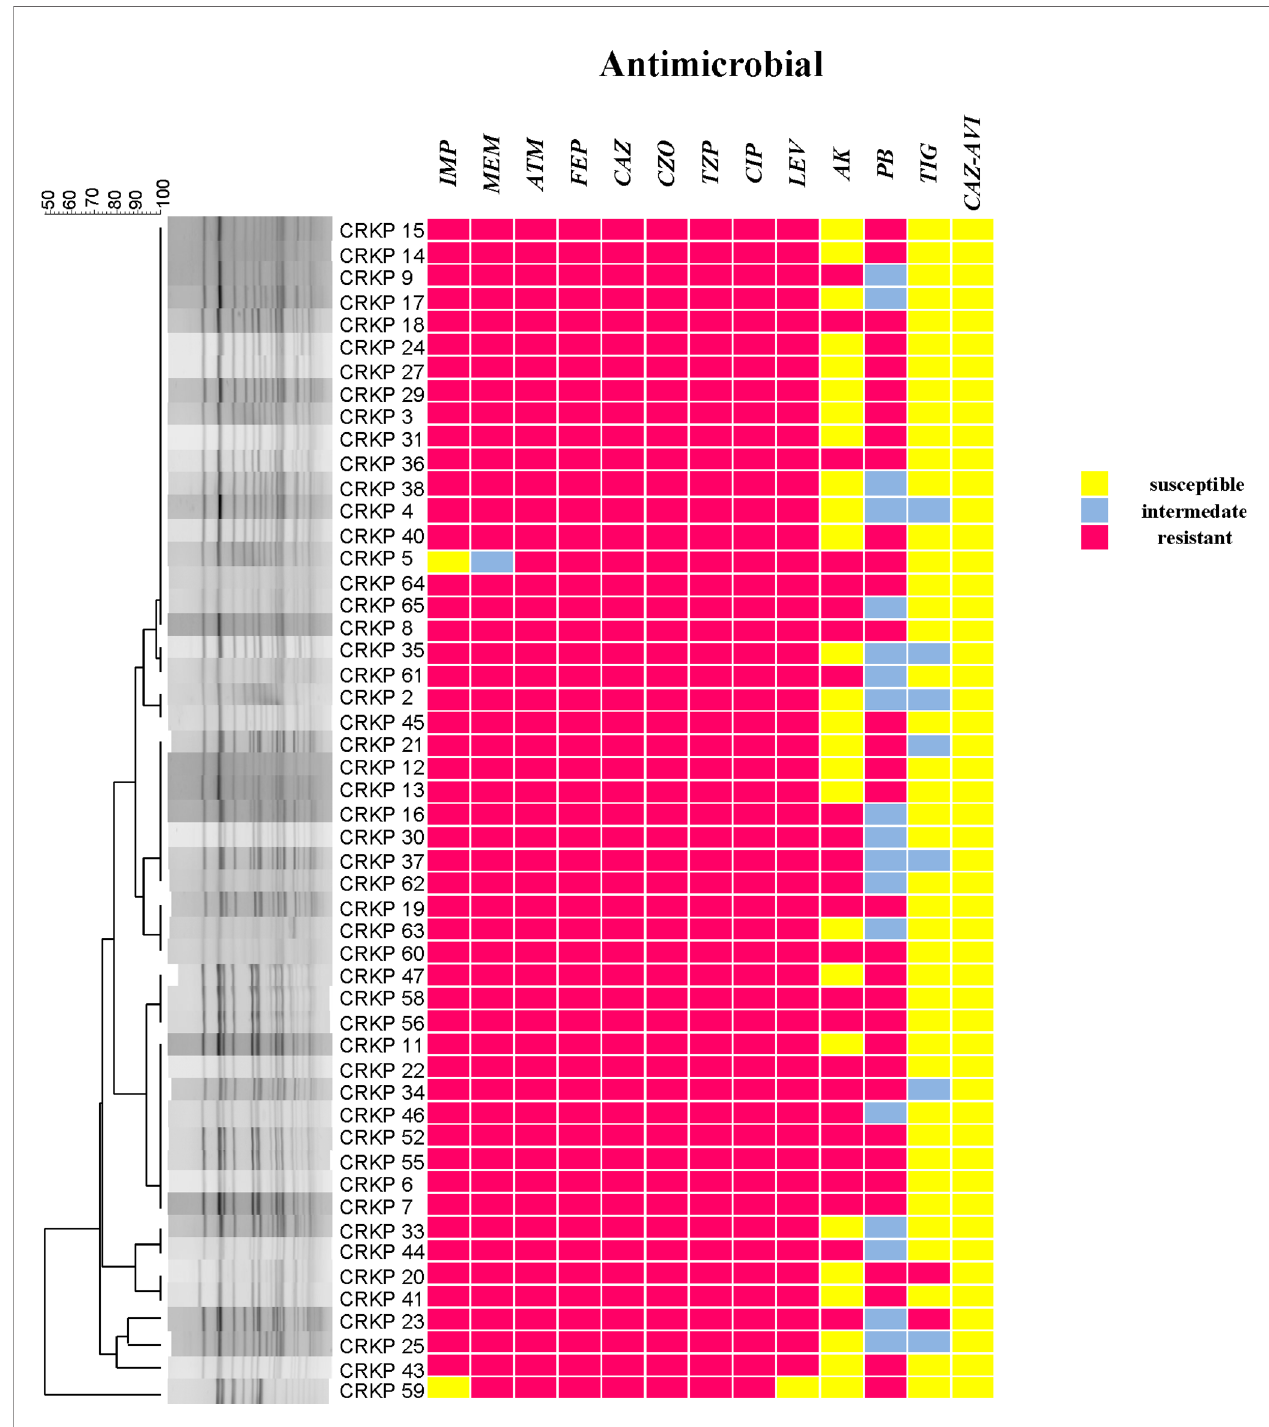
FIGURE 2 | CRKP genetic similarity and antibiotic sensitivity. IMP, Imipenem; MEM, Meropenem; ATM, Aztreonam; FEP, Cefepime; CAZ, Ceftazidime; CZO, Cefazolin; TZP, Piperacillin tazobactam; CIP, Cipro fl oxacin; LEV, Levo fl oxacin; AK, Amikacin; PB, Polymyxin B; TIG, Tigecycline; CAZ – AVI, ceftazidime –